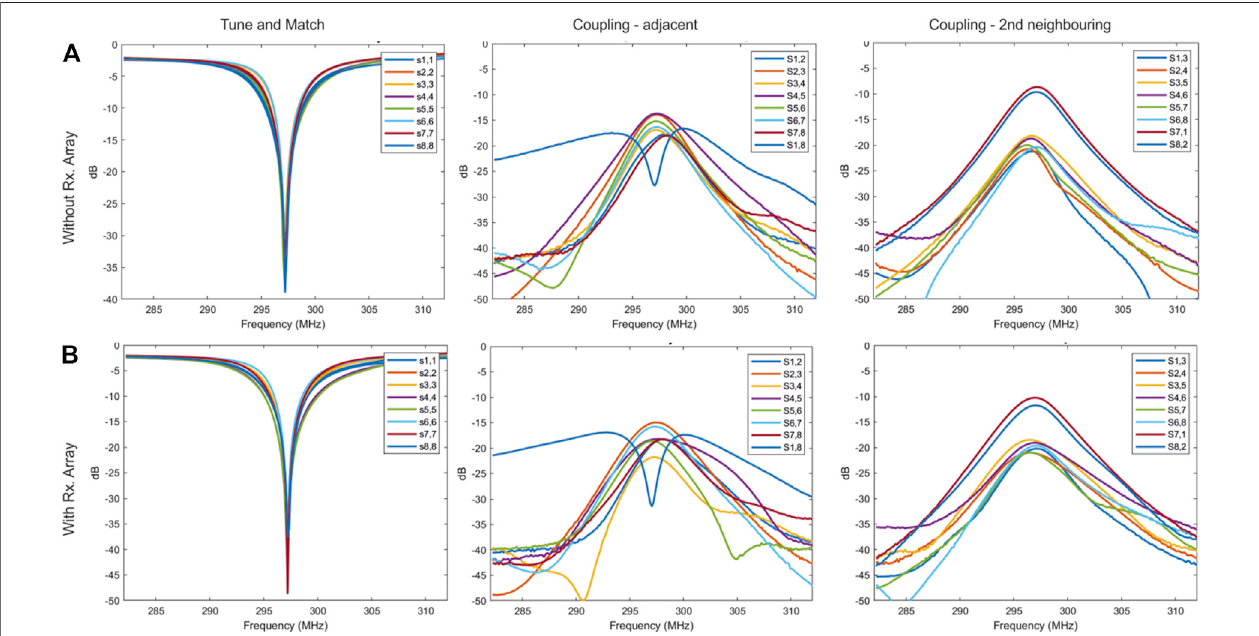
FIGURE 6 | (A,B) Measured S-parameter plots of the re fl ection, adjacent element and next-neighbouring element coupling of the constructed transmit array without the receive array (A) and with the receive array (B) .